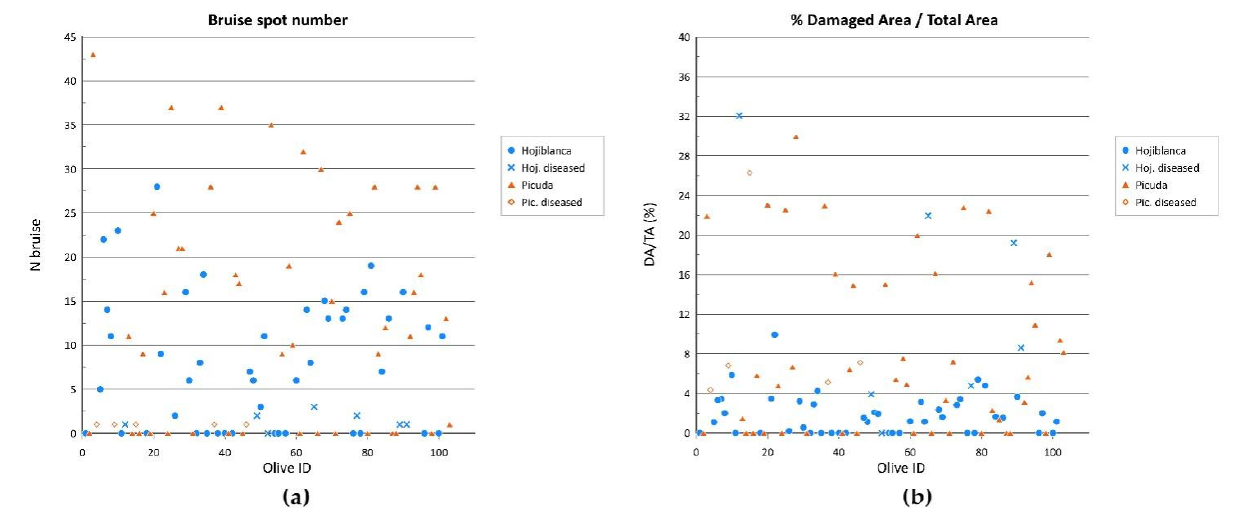
Figure 17. ( a ) Number of spot bruised distribution, ( b ) Percentage of damaged area versus total area.